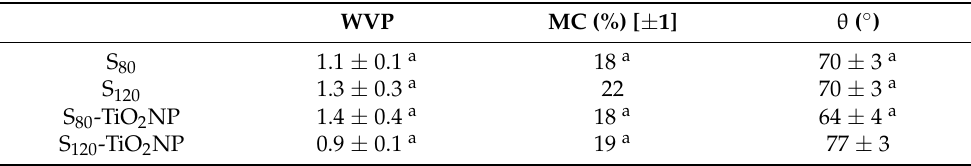
Table 2. Results of water vapor permeability (WVP), moisture content (MC) and contact angle ( θ ) of the developed